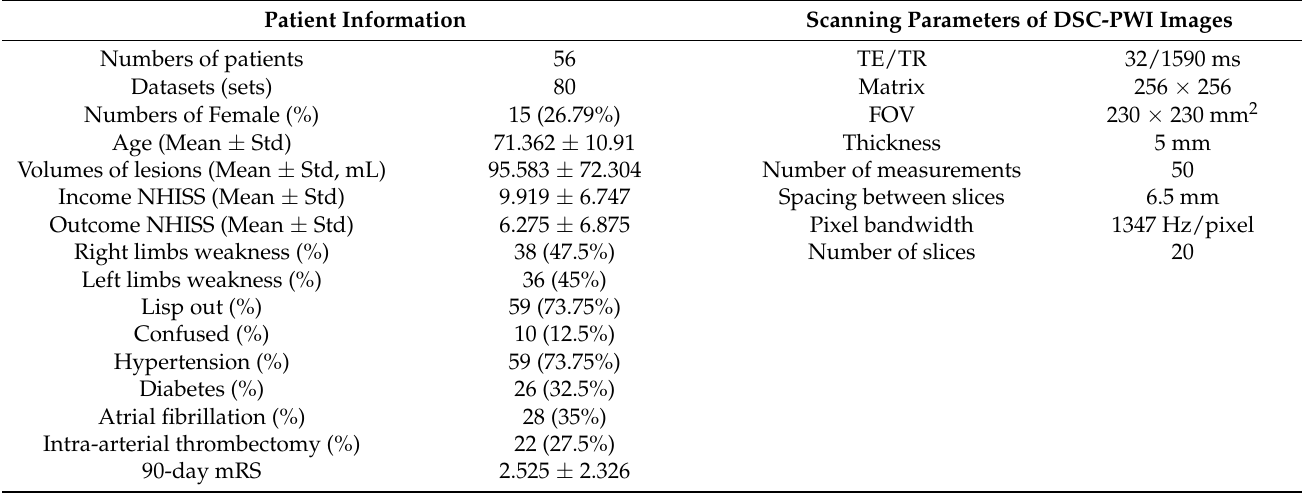
Table 1. Patient information and scanning parameters of DSC-PWI